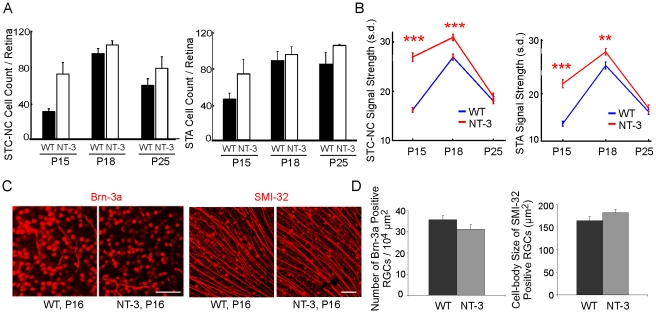
NT-3 OE mice exhibit stronger STC-NC signal strength at P15 and at P18.(A) Average cell count for NT-3 OE and WT controls at the three ages analyzed by the STC-NC or the STA method. (B) Plot of the STC-NC or the STA signal strength in s.d. against mouse age for WT and NT-3 OE mice. (C–D) Immunostainings with Brn-3a and SMI-32 antibodies demonstrated that WT and NT-3 OE retinas did not differ in total RGC number or cell body size at P16. Error bars represent S.E.M. throughout. ***: p<0.001; **: p<0.01; *: p<0.05 in Student's t-test.